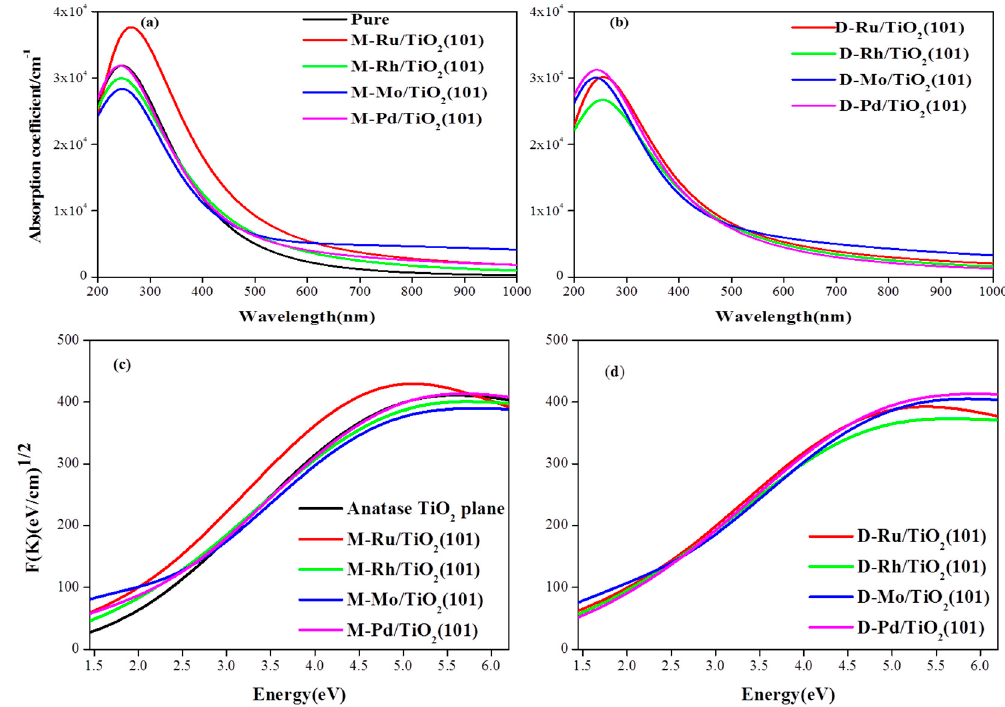
Figure 5. The optical absorption spectra of different adsorption structures: ( a ) the anatase TiO 2 (101) plane and M/TiO 2 (101) with the monoatomic adsorption structures; ( b ) the M/TiO 2 (101) with the diatomic adsorption structure; ( c , d ) the Tauc plots of M/TiO 2 (101) with the monoatomic and diatomic adsorption structures, respectively.